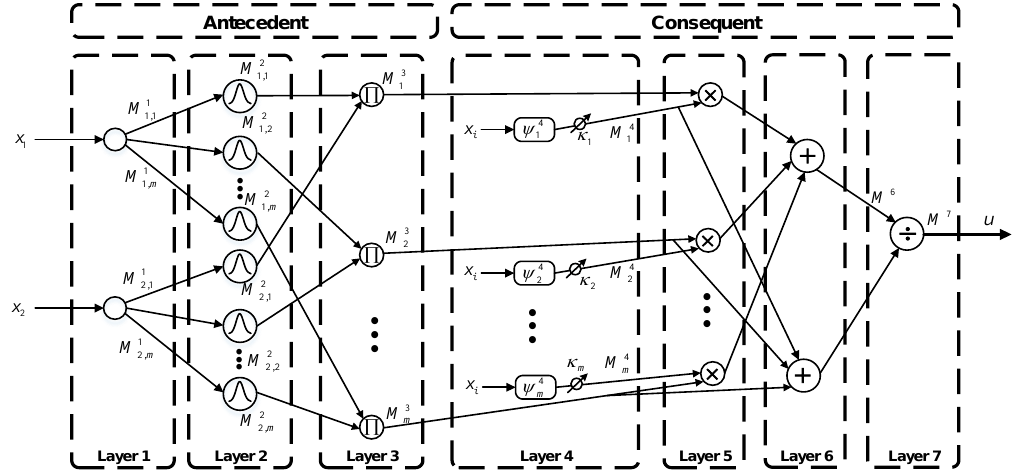
Figure 6. Structure of the adaptive neuro-fuzzy Jacobi wavelet (ANFJW) controller.